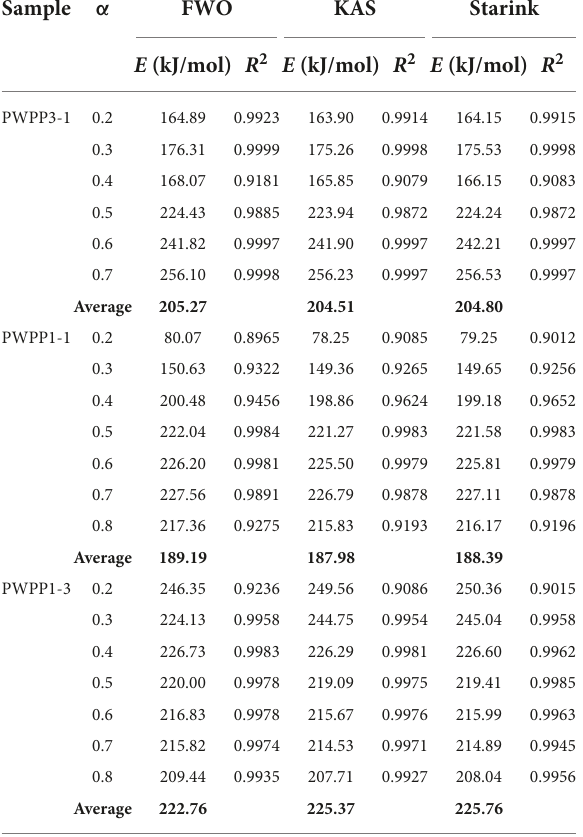
TABLE 7 Kinetics parameters of PW and PP mixtures solved by isoconversional methods. Sample